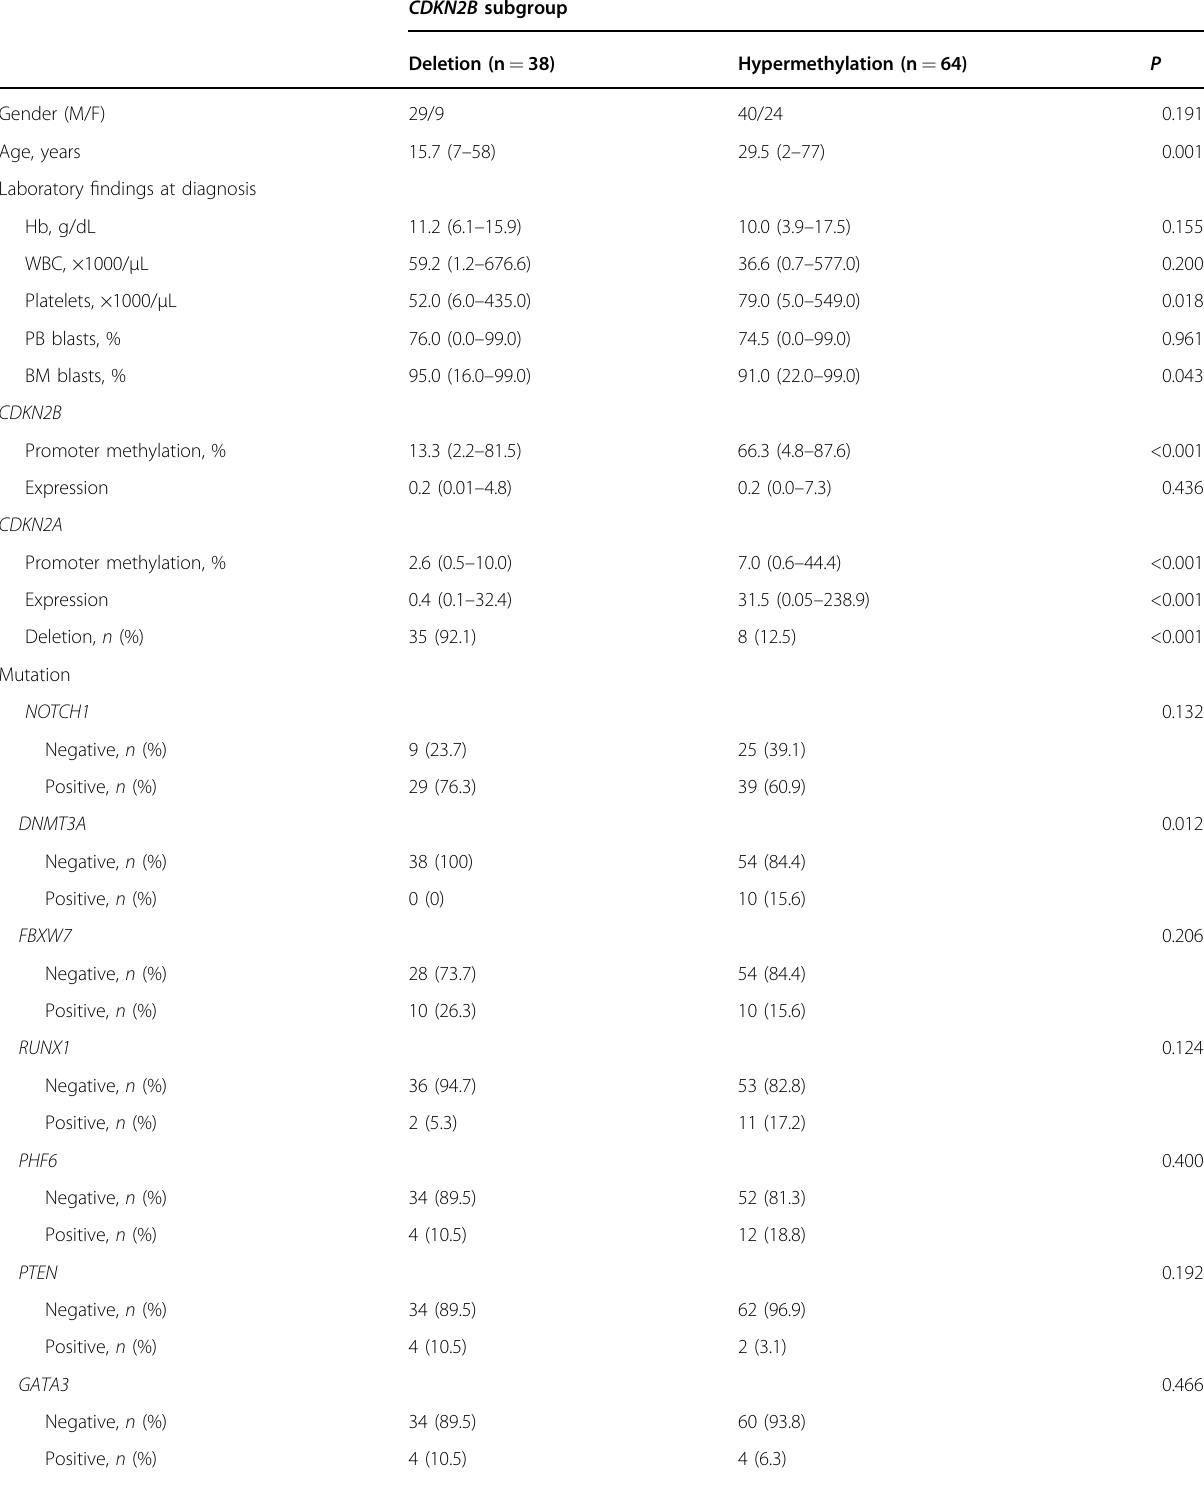
Table 2 Comparison of characteristics and outcome between patients with CDKN2B deletion and